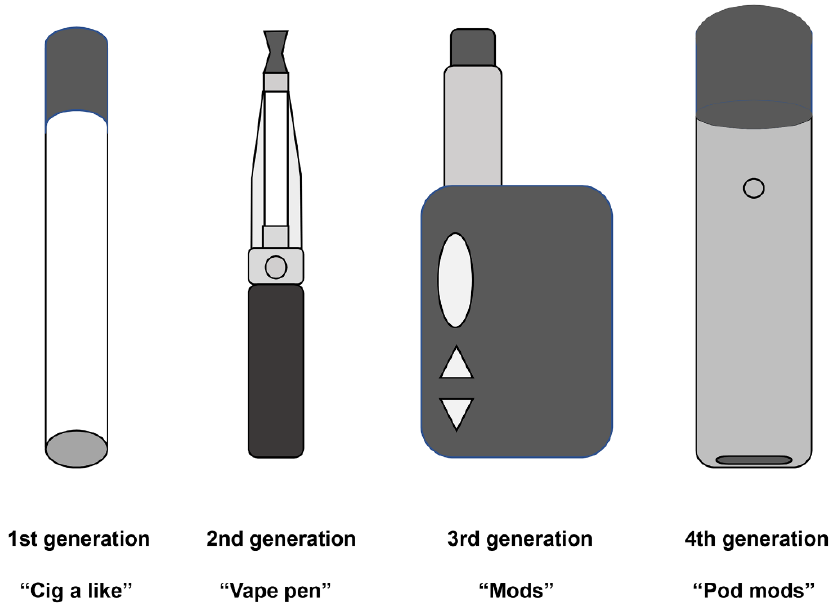
Figure 1. Schematics of the four generations of e-cigarettes.